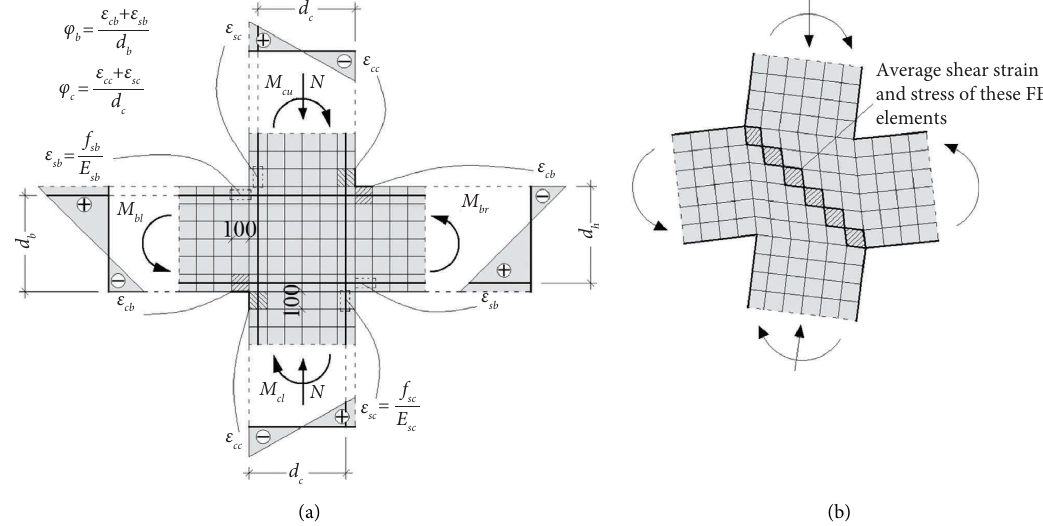
Figure 9: Determination of the deformation of structural members from 2D continuum FE models. (a) Flexural deformation of beams and columns. (b) Shear stress and deformation of